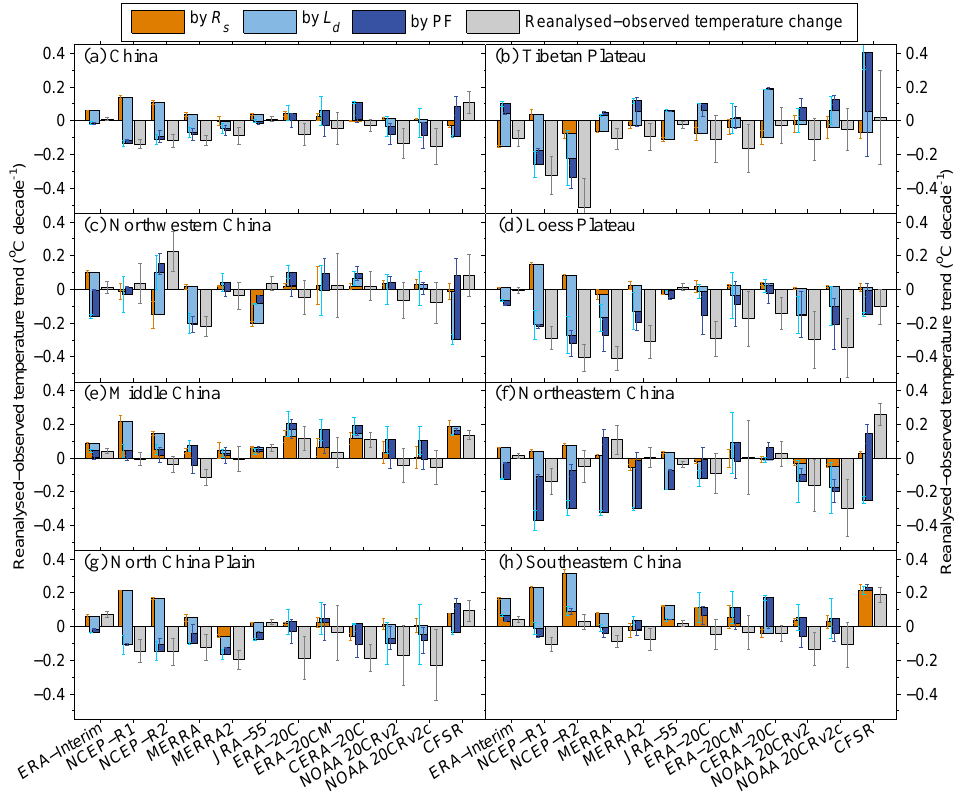
Figure 7. Contributions (unit: ◦ Cdecade − 1 ) of the biases in the trends in surface air temperatures ( T a ) from three relevant parameters, surface incident solar radiation ( R s , in brown), surface downward longwave radiation ( L d , in light blue) and precipitation frequency (PF, in deep blue), during the study period of 1979–2010 from the 12 reanalysis products over China and its seven subregions.